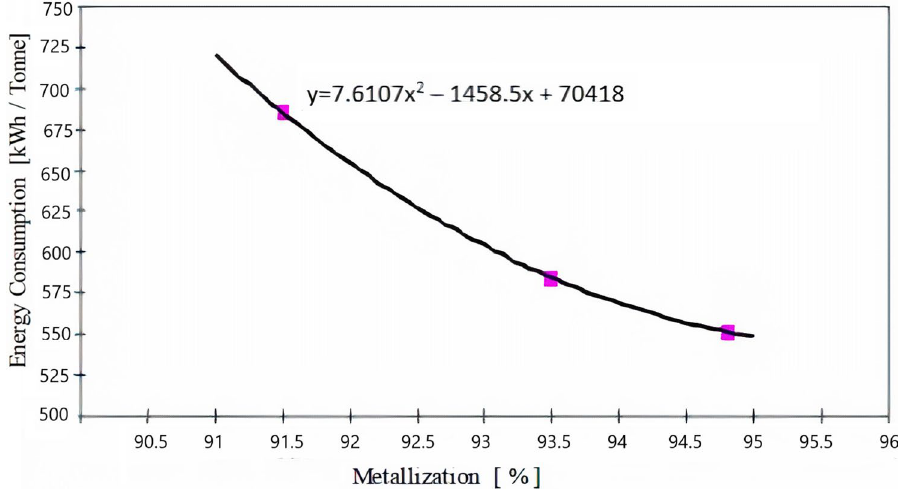
Fig. 15 Energy consumption vs metallization [14]